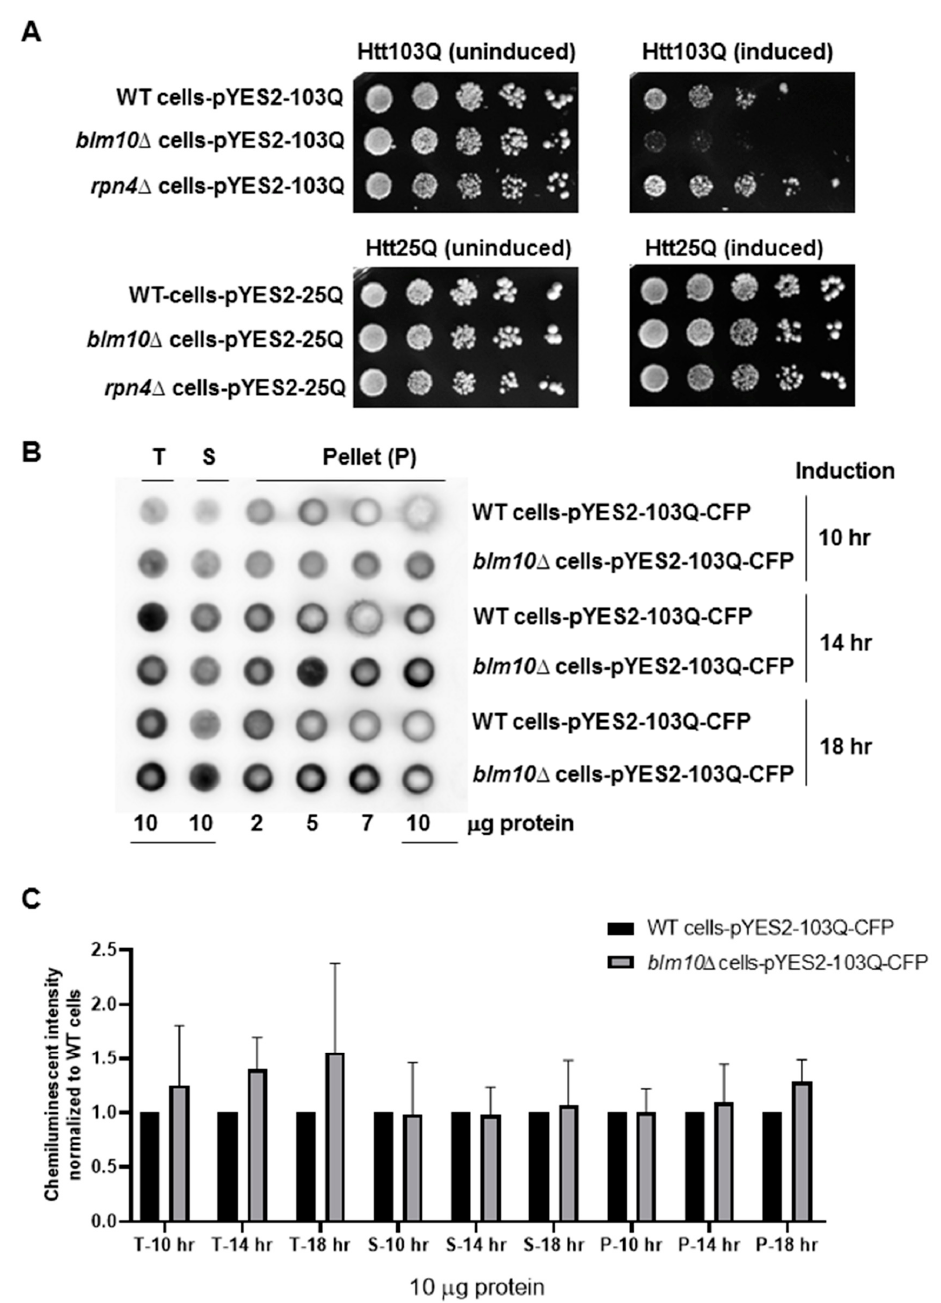
Figure 1. Cellular toxicity and aggregation of toxic N-terminal Htt fragments (N-Htt) in wild type (wt) and blm10 ∆ cells. ( A ) The expression of toxic huntingtin fragments impedes growth in the absence of BLM10 . Wild type (wt), blm10 ∆ , rpn4 ∆ cells harboring Htt103Q (upper panels), and Htt25Q (lower panels were grown in galactose (induced) or ra ffi nose-containing media (un-induced) for 18 h and spotted onto synthetic media plates. ( B ) Htt103Q aggregation in wt and blm10 ∆ cells. Expression of Htt103Q was induced by 2% galactose for the times indicated and a filter retardation assay was performed in wt and blm10 ∆ cells. The indicated protein amount of the total lysate (T), supernatant (S), and aggregate-containing pellet (P) were loaded. Htt103Q levels were detected with an anti-GFP antibody. ( C ) Quantitative analysis of SDS-insoluble aggregates in blm10 ∆ cells normalized to wt. Data are presented as mean values ± SD for four independent experiments. Data were analyzed using Image studio lite version 5.2 software. Statistical analysis was performed using ANOVA test by GraphPad Prism